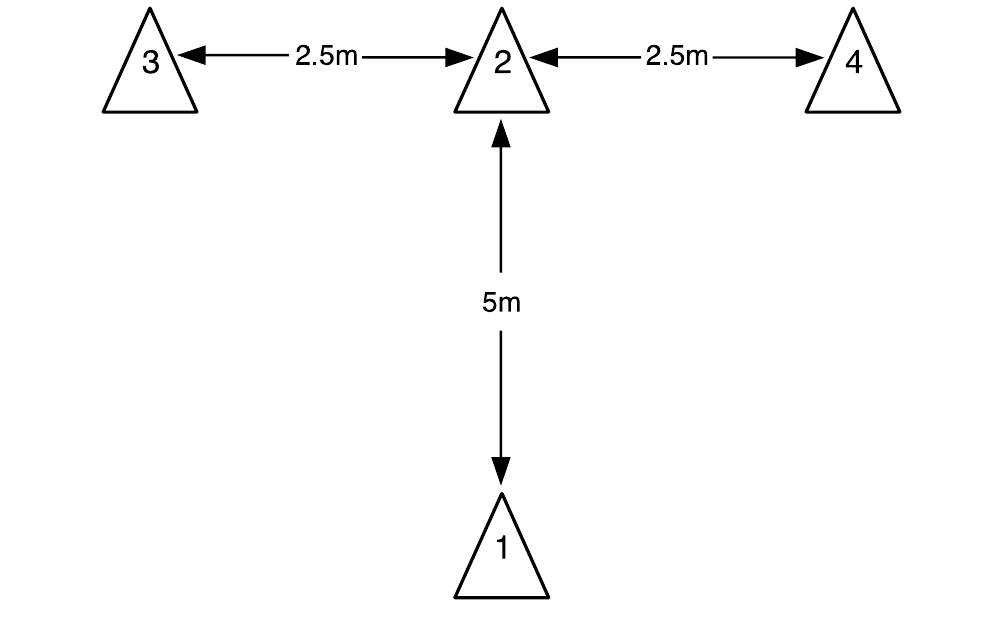
Figure 1. Schematic presentation of the modified agility T-test.